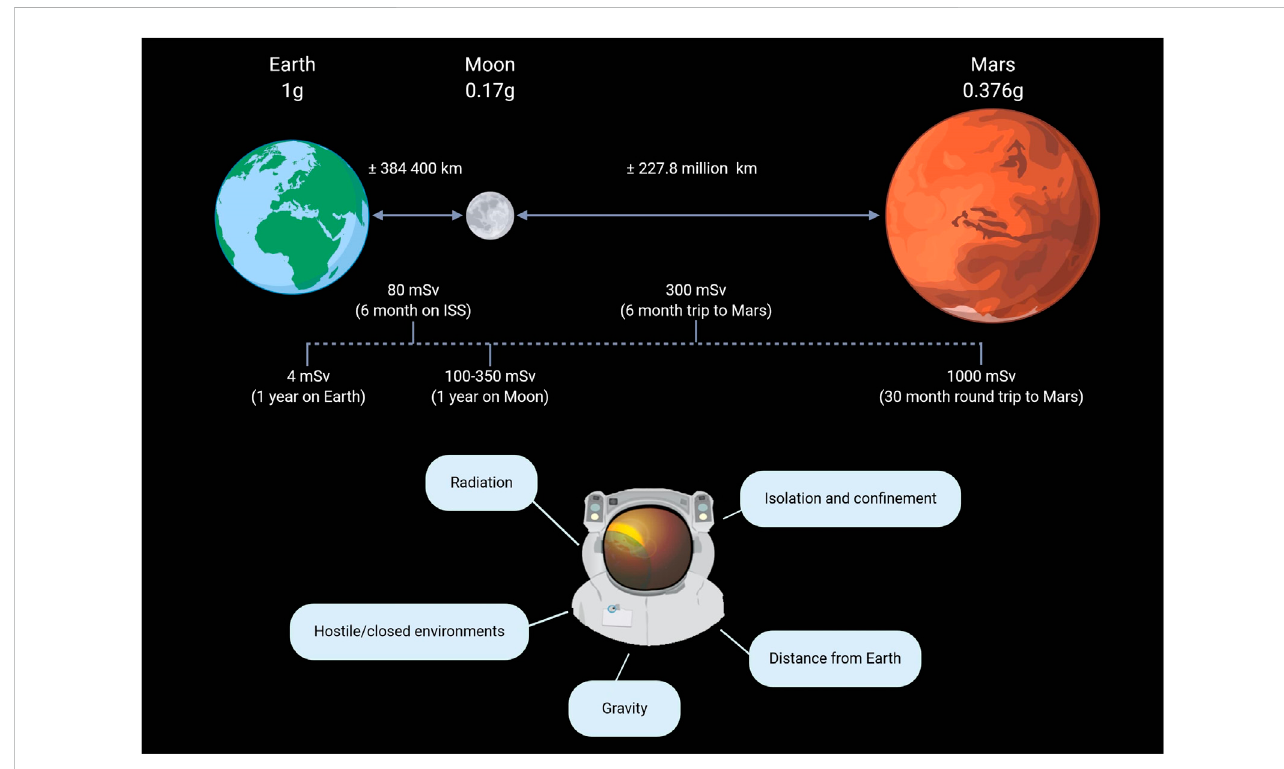
FIGURE 1 Encountered levels of microgravity and radiation in space as well as the fi ve major hazards of human space fl ight. Reproduced from Moroni et al. (2022) with permission from Elseviere.